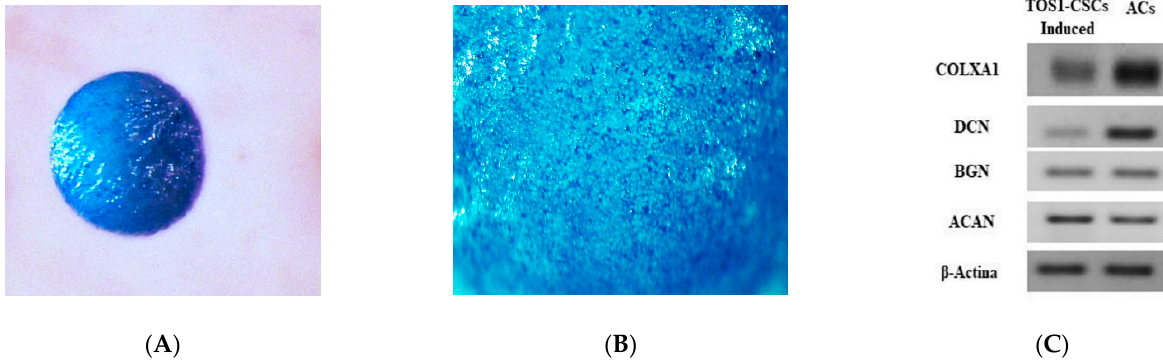
Figure 6. Chondrogenic differentiation assay and expression of hyaline-chondrogenic gene markers. Histological evaluation of TOS1-CSC condrogenic 3Dimensional cell pellet at 21 days ( A ). Alcian Blue stain demonstrates positive glycosaminoglycan production ( B ). Stereomicroscopy images. Original magnification: 16× and 40×. ( C ) RT-PCR show the expression of COLXA1, DCN, BGN, and ACAN in TOS1-CSCs (left) compared to their expression in a primary cell line of human articular chondrocytes (ACs) (control) (right) after 21 days of chondrogenic induction.